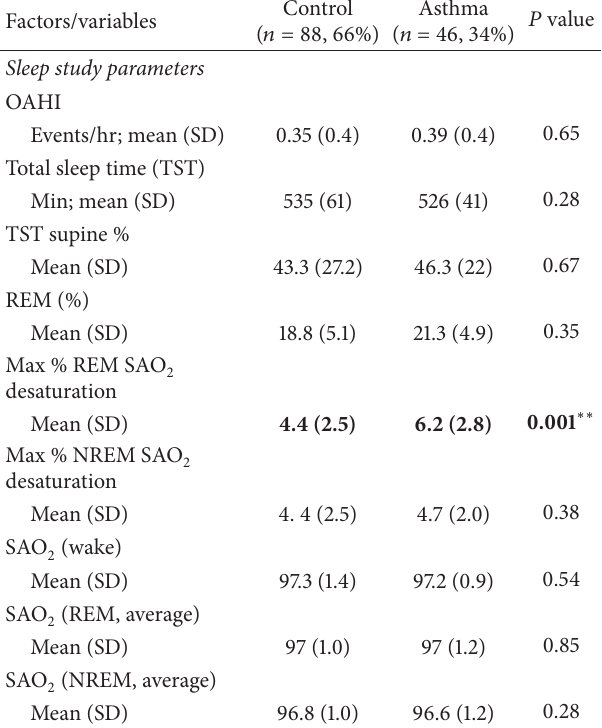
Table 2: Polysomnographic parameters of subjects. Table 3: Multivariate regression analysis results for the association between rhinitis and REM-OAHI adjusted by